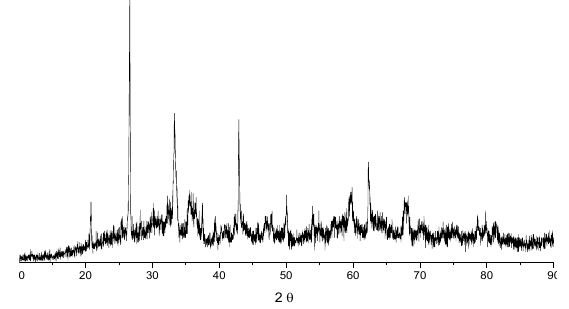
Fig. 2. Diffractogram of fly ash from PT.